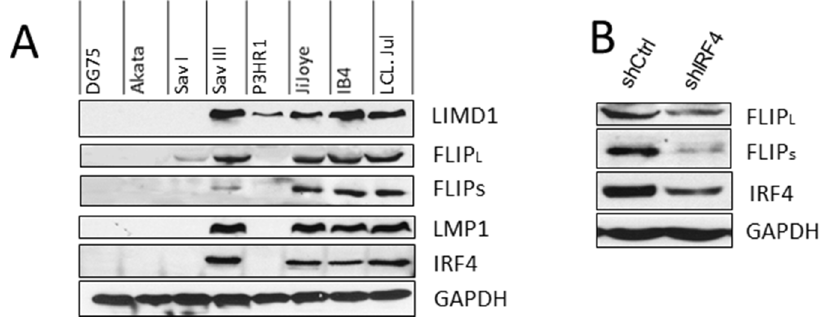
Figure 4. Verification of the correlation of IRF4 with LIMD1 and CFLAR. A . A panel of EBV-negative and -positive B cell lines were subjected for immunoblotting analysis for IRF4, LIMD1, CFLAR (c-Flip), and LMP1 expression, with specific antibodies. DG75: EBV-negative. Akata and SavI: EBV- positive with Type I latency. SavIII, P3HR1, and JiJoye were derived from EBV + Burkitt’s lymphomas. IB4 and LCL.Jul are LCLs established in vitro by EBV transformation. B . Knockdown of IRF4 in JiJoye cells downregulates the c-Flip protein level in JiJoye cells.